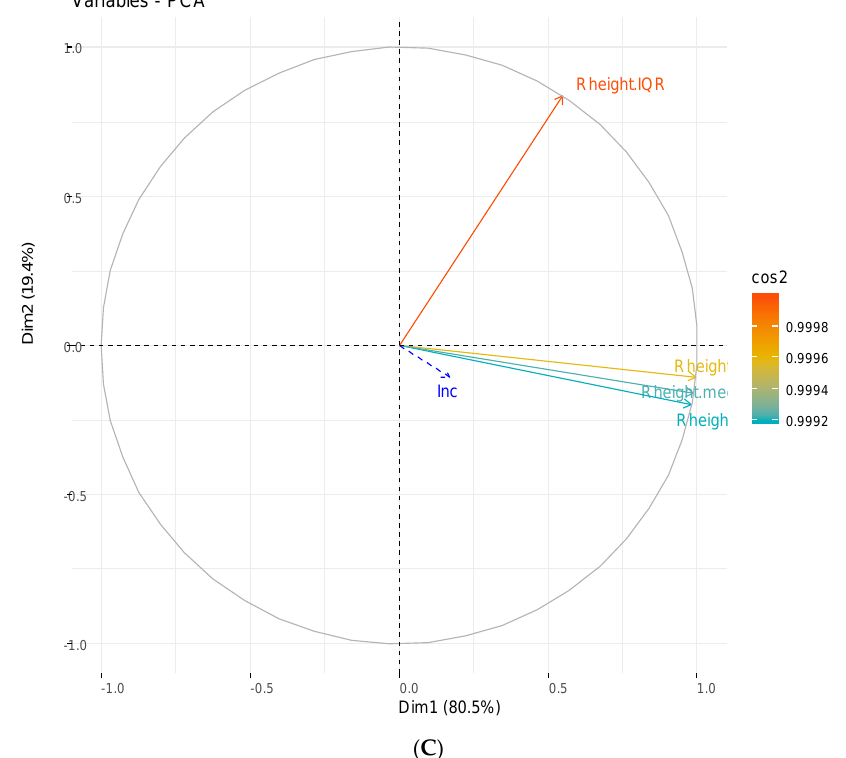
Figure 4. Principal component analysis (PCA) of meteorological and hydrological components for Dangassa study site. ( A ) Represents the two first components for meteorological components, ( B ) the 2nd and 3rd components and ( C ) represents the two first components for hydrological components. For the Koila study site, the first component (Kmt1, 34.80% of the inertia) consisted of humidity, rain, and minimum temperature, in opposition to the wind speed. The second component, (Kmt2, 27.50% of the inertia), consisted of the maximum temperature, opposed to vegetation indices (NDVI). The third component, (Kmt3, 8.00% of the inertia), consisted of the variations of all the meteorological components.